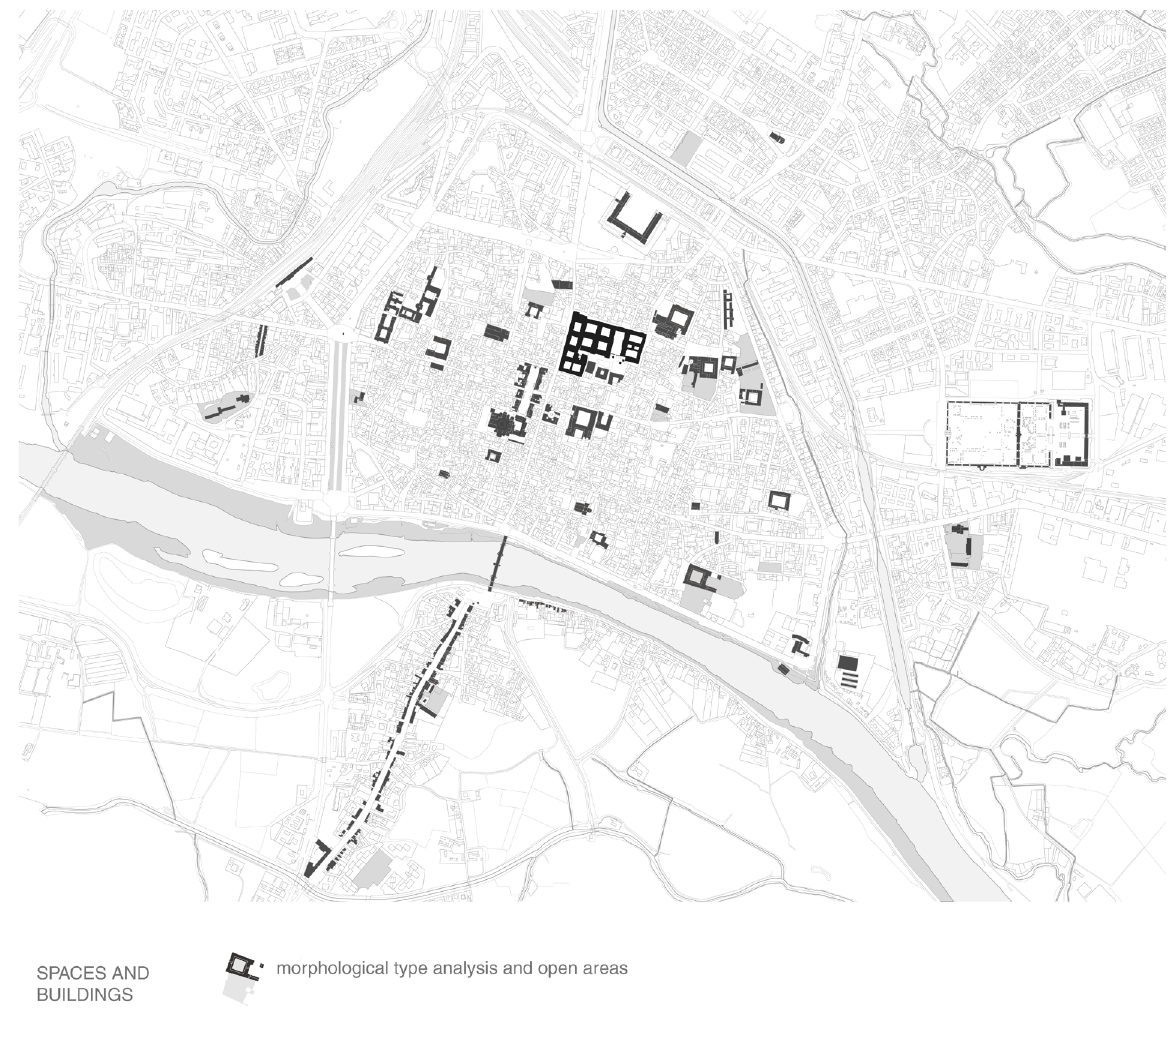
Mapping of significant spaces and buildings in Pavia through their FIG. typo-morphological Features (drawing by authors).